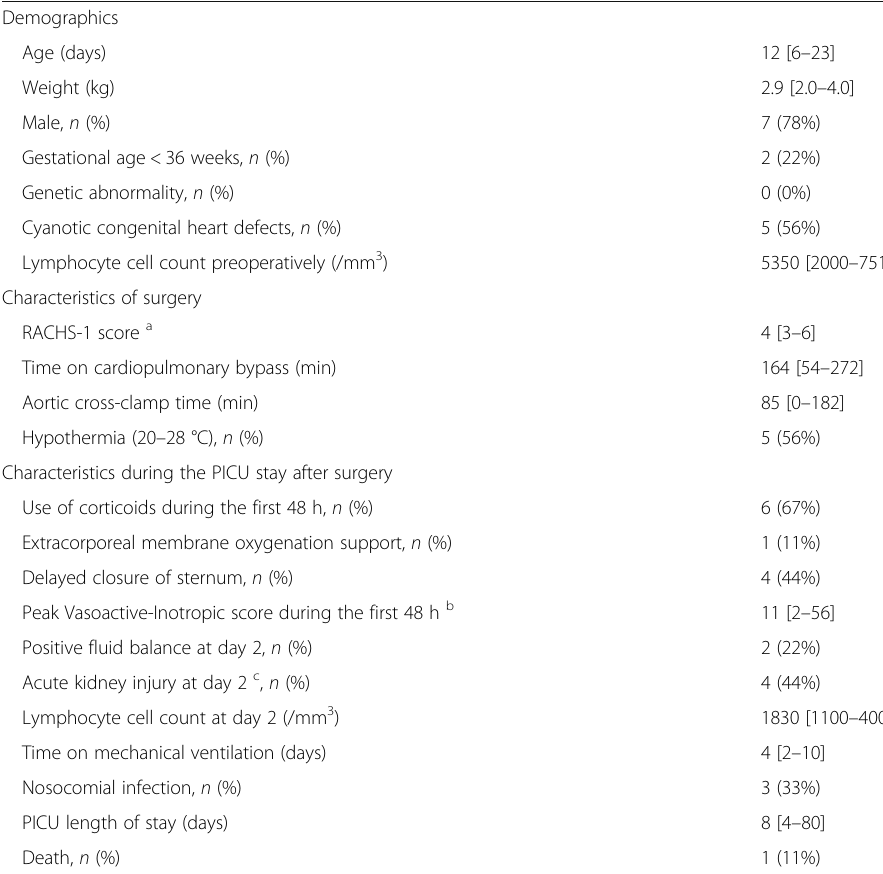
Table 1 Characteristics of patients ( n = 9)